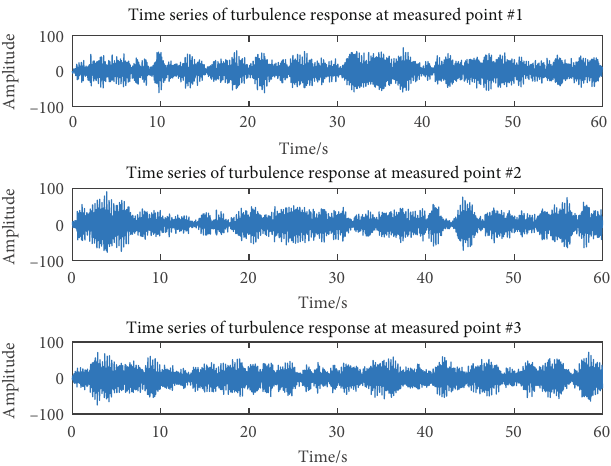
Figure 4: System identi fi cation